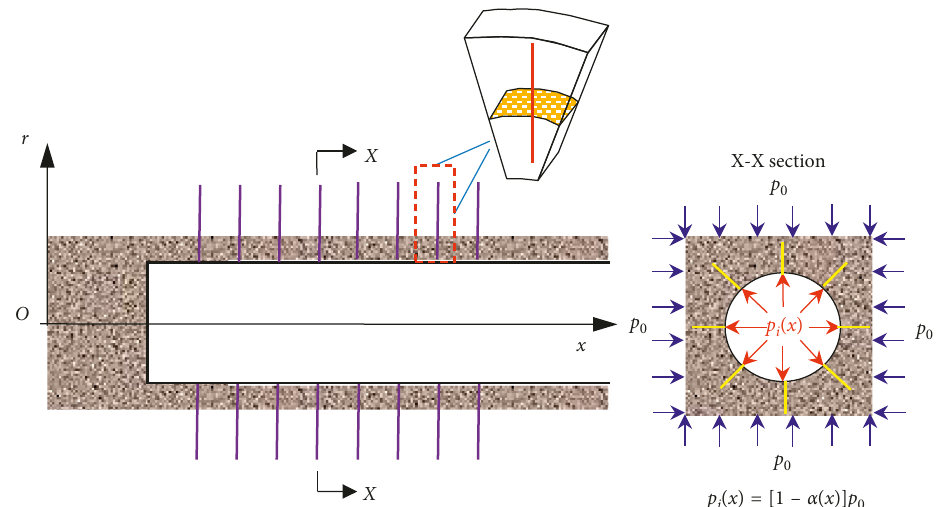
Figure 2: 2D semianalysis model for the full-face anchorage of the weakly cemented soft rock roadway.